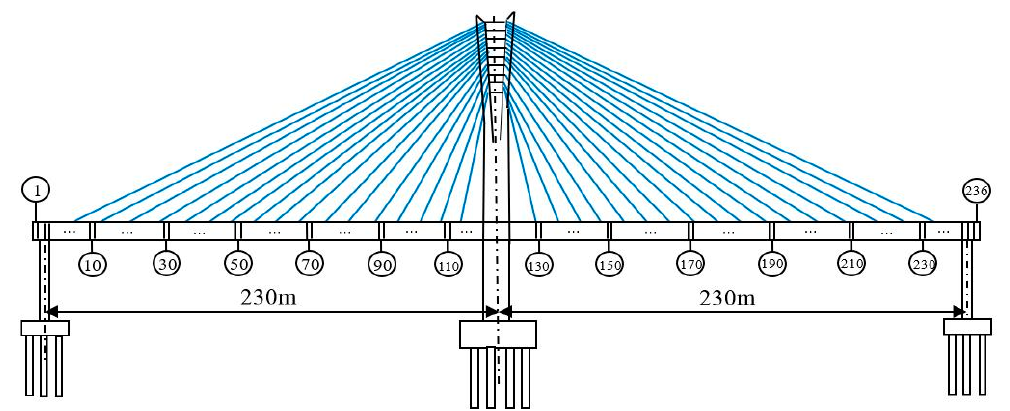
Figure 6. Schematic diagram of a two-dimensional model of a cable-stayed bridge. Table 1. The main structural parameters of the main bridge.